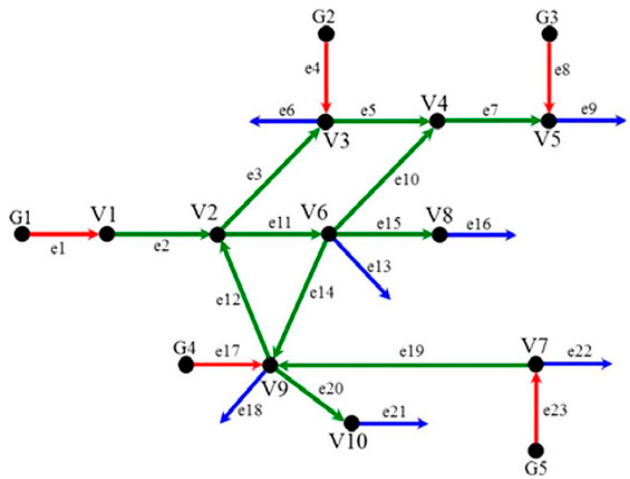
Figure 1. Message flow among agents for our load shedding system.